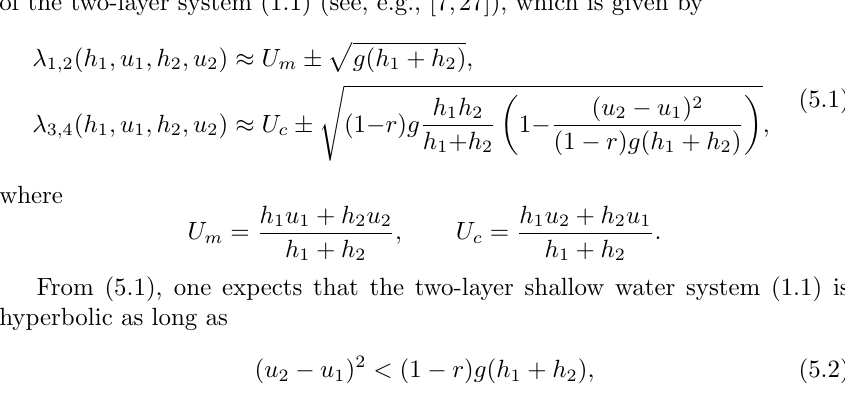
small value of (cid:98) h m = 0 . 05, and as (cid:98) h m is increased (see Figures 10 and 11),